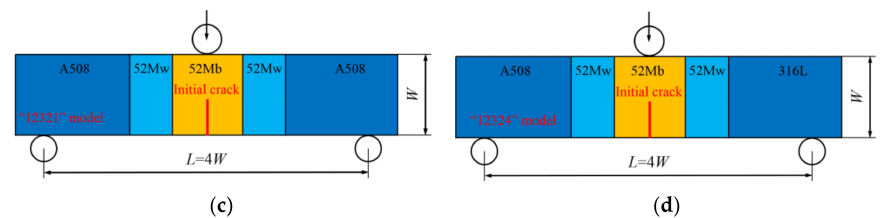
Figure 3. Four different basic models, ( a ) “121” model, ( b ) “123” model, ( c ) “12321” model and ( d ) “12324” model.